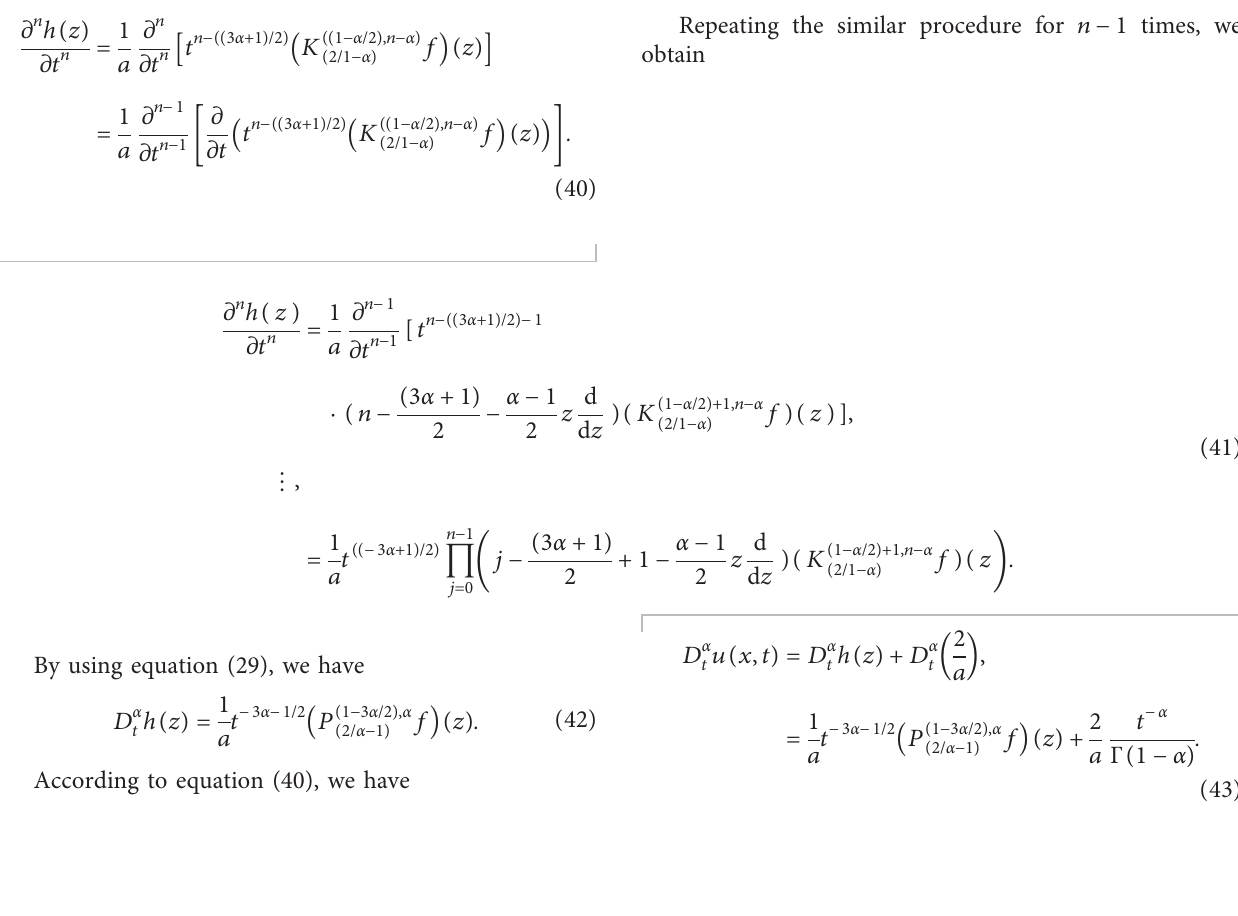
� c � 1, α � 0 . 99, a � 2, and b � 0 1